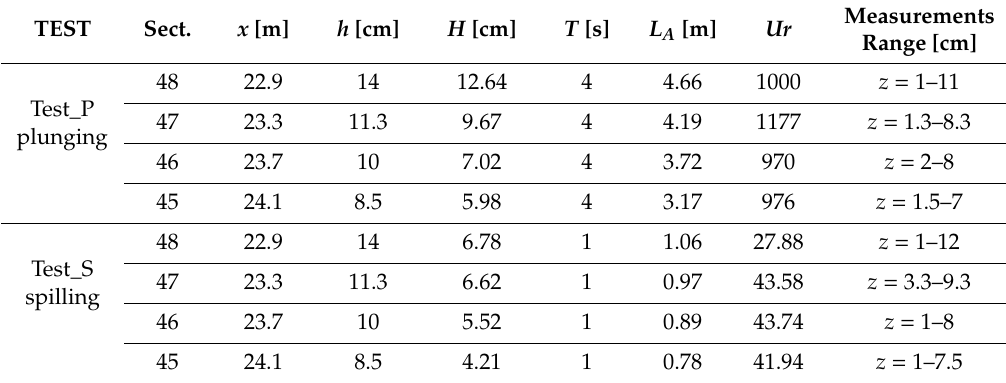
Table 1. Main characteristics of the two tested regular wave